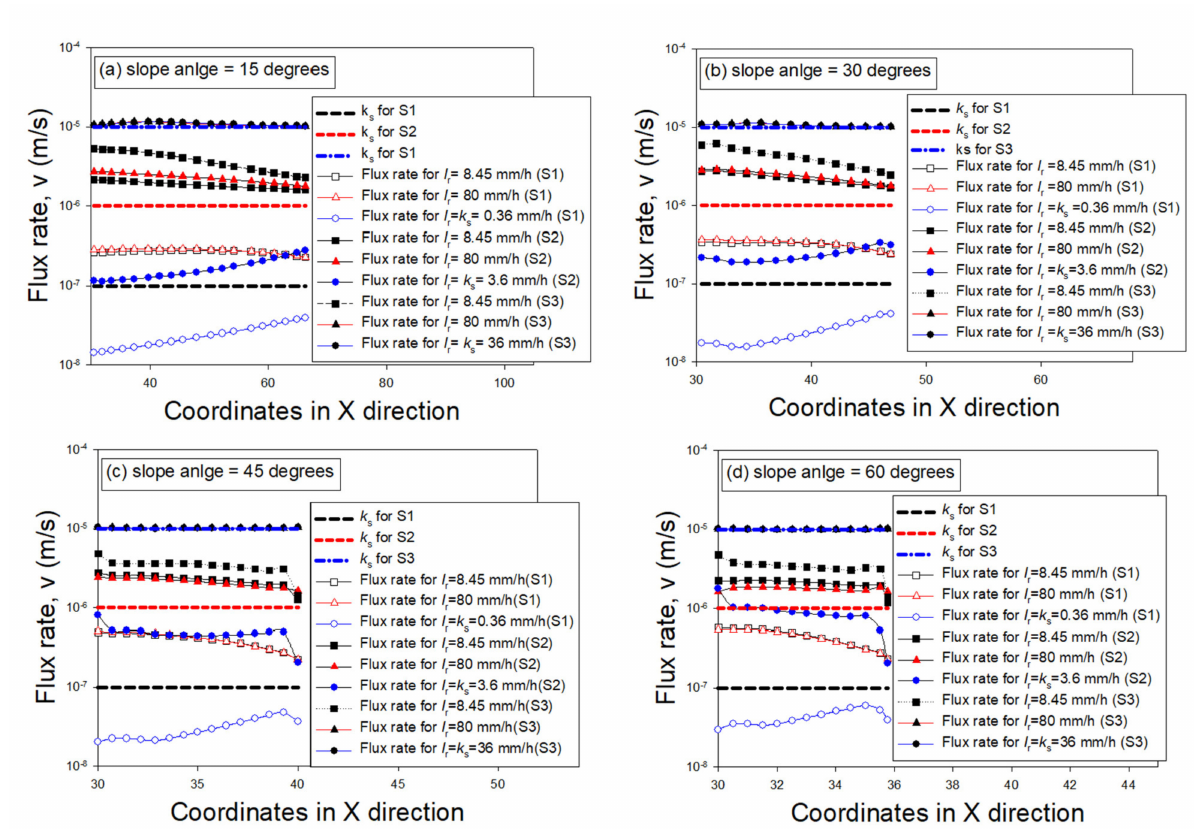
Figure 7. The flux rate near the slope surface, ( a ) α = 15 ◦ ; ( b ) α = 30 ◦ ; ( c ) α = 45 ◦ ; ( d ) α = 60 ◦